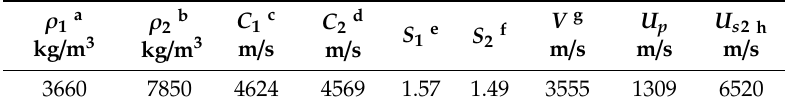
Table 3. Values of the impact